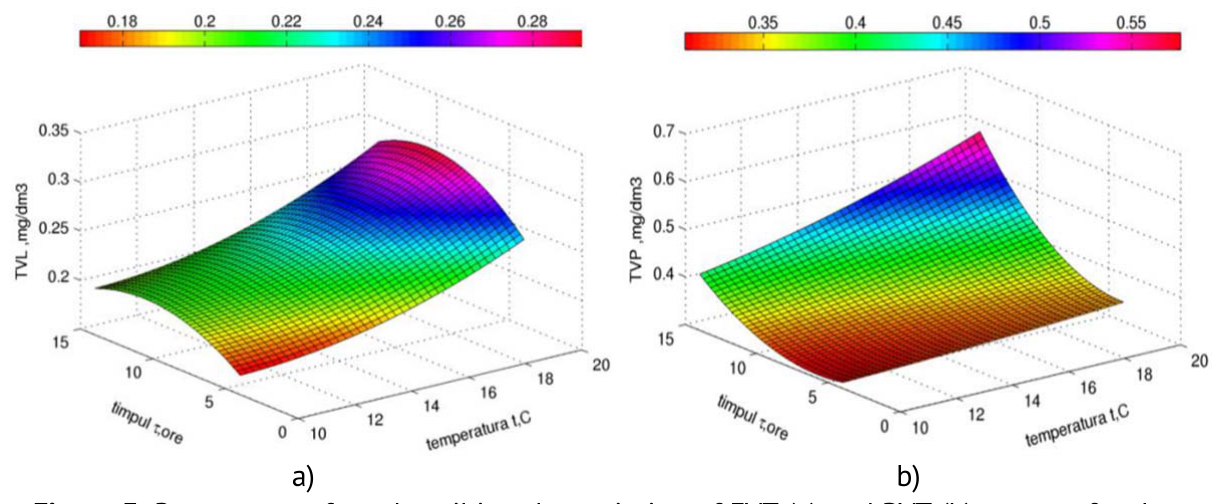
Figure 3. Response surface describing the variation of FVT (a) and PVT (b) content for the Viorica variety wines depending on temperature and